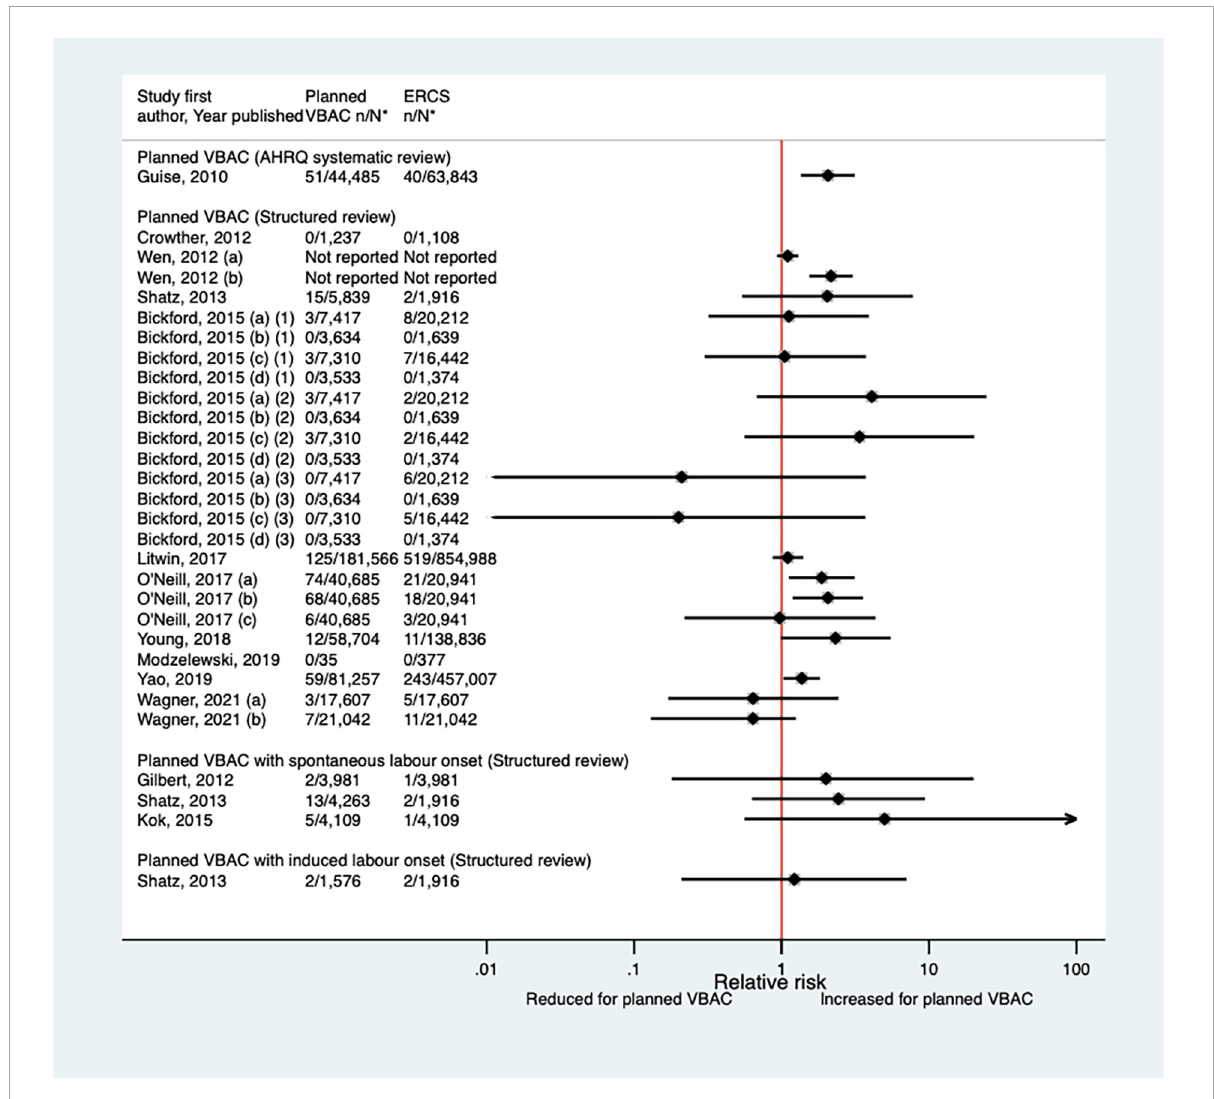
FIGURE8 Risk of neonatal mortality for planned VBAC vs. ERCS. ∗ n , number in group with the outcome; N , Total number in group. Wen et al. (42) (a) outcome: all cause neonatal death, (b) outcome: asphyxia associated neonatal death; Bickford and Janssen (50) (a) risk in women with 1–2 prior CSs only, (b) risk in women with 1–2 prior CSs and ≥ 1 prior VB, (c) risk in women with 1 prior CS only, (d) risk in women with 1 prior CS and ≥ 1 prior VB, (1) outcome: death at ≤ 28 days of birth, (2) outcome: death at ≤ 7 days of birth, (3) outcome: death at 8–28 days of birth; O’Neill et al. (60) (a) outcome: death at ≤ 28 days of birth, (b) outcome: death at ≤ 7 days of birth, (c) outcome: death at 8–28 days of birth. Wagner et al. (77) (a) Risk in women with no prior vaginal births. (b) Risk in women with ≥ 1 prior vaginal birth. AHRQ, Agency for Healthcare Research and quality; CS, cesarean section; ERCS, elective repeat cesarean section; VBAC, vaginal birth after previous cesarean; VB, vaginal birth.